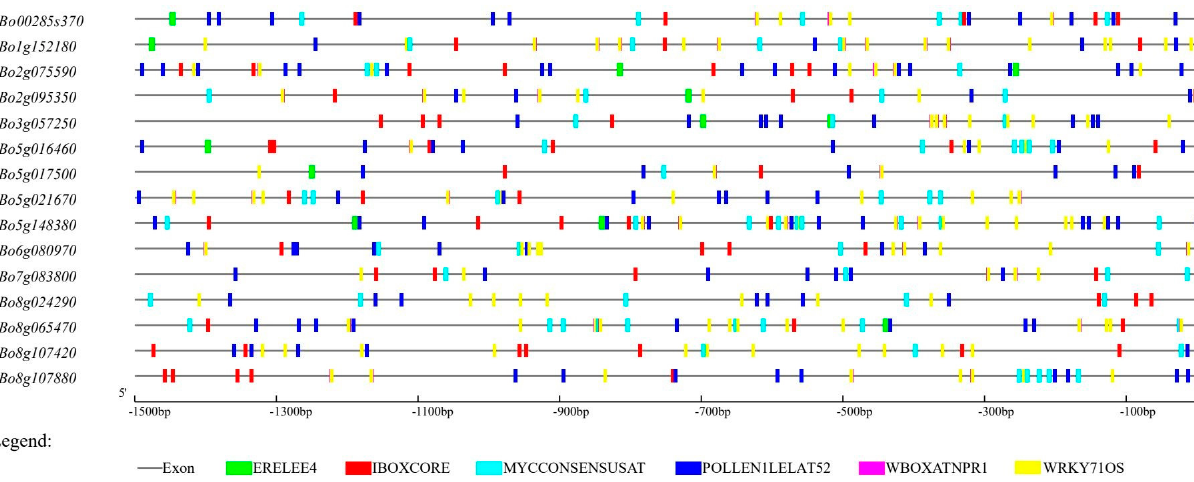
Figure 4. Analysis of cis-acting elements in the promoter region of the GAPDH gene in B. oleracea . ERELEE4: ethylene response element; IBOXCORE: light response element; MYCCONSENSUSAT: response element related to dehydration reaction and abscisic acid signal transduction in Arabidopsis ; POLLENLELAT52: pollen-specific cis-acting element; WBOXATNPR1: pressure- and defense-related response element; WRKY71OS: anti-elements related to gibberellin signaling.